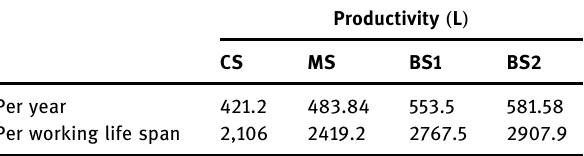
Table 6: Economic feasibility of the solar